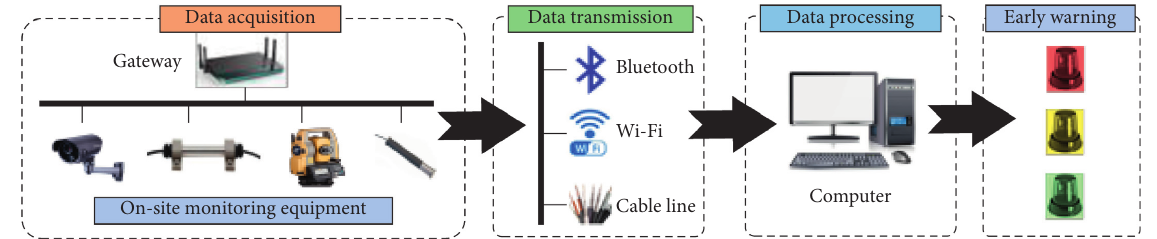
Figure 1: Overall architecture of the monitoring system.